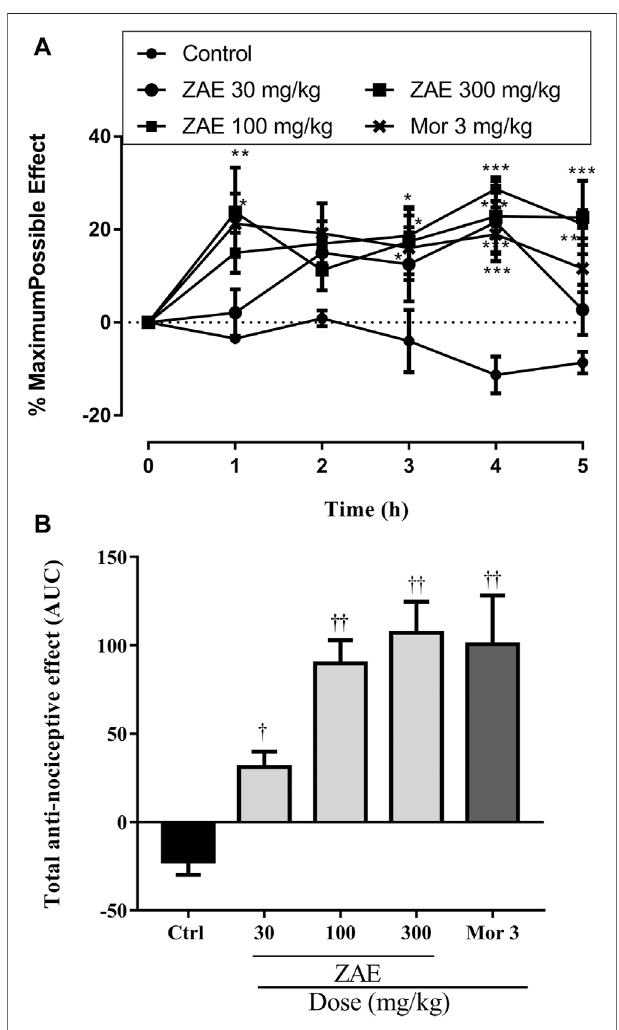
FIGURE 2 | The total anti-nociceptive effect of three doses of ZAE and morphinepresented (A) time-coursecurvesofthevarioustreatmentsover5 h and (B) areas under the curve (AUC) in tail-immersion test in mice. The symbols* p < 0.05;** p < 0.01;*** p < 0.001denotesigni fi cantdifferences in time-course curves of treatment compared to the control (Ctrl) group (two- way ANOVA followed by Dunnet ’ s multiple comparison test) whereas † p < 0.05, †† p < 0.01, ††† p < 0.001 denote signi fi cant differences of treatment in comparison with control (Ctrl) group using the one-way ANOVA followed by Tukey ’ s multiple comparison test.